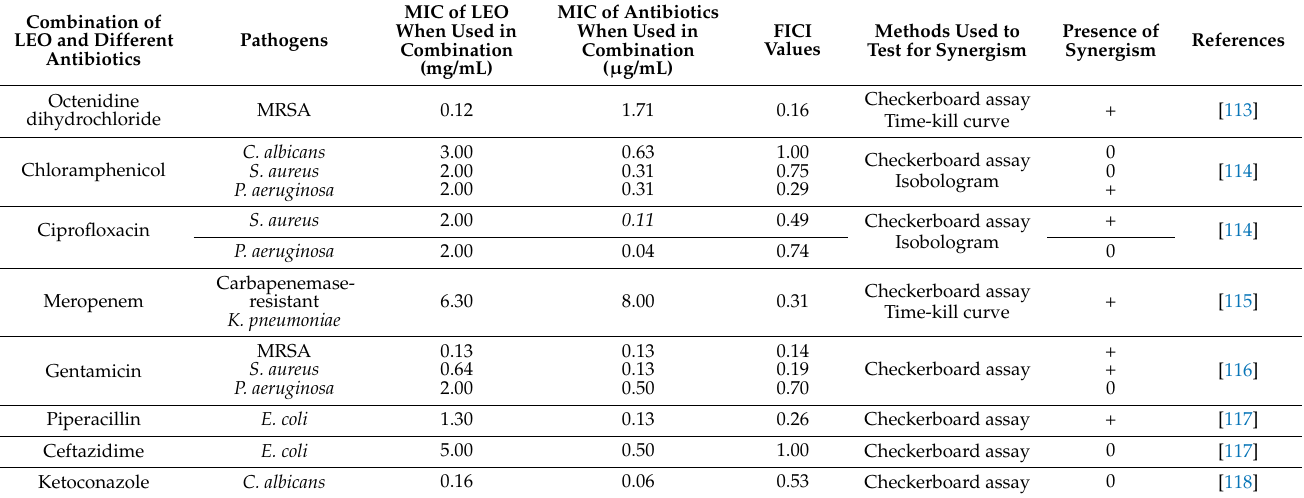
Table 4. Synergistic effects exhibited by LEO when used in combination with other antibiotics from different in vitro studies. Combination of LEO and